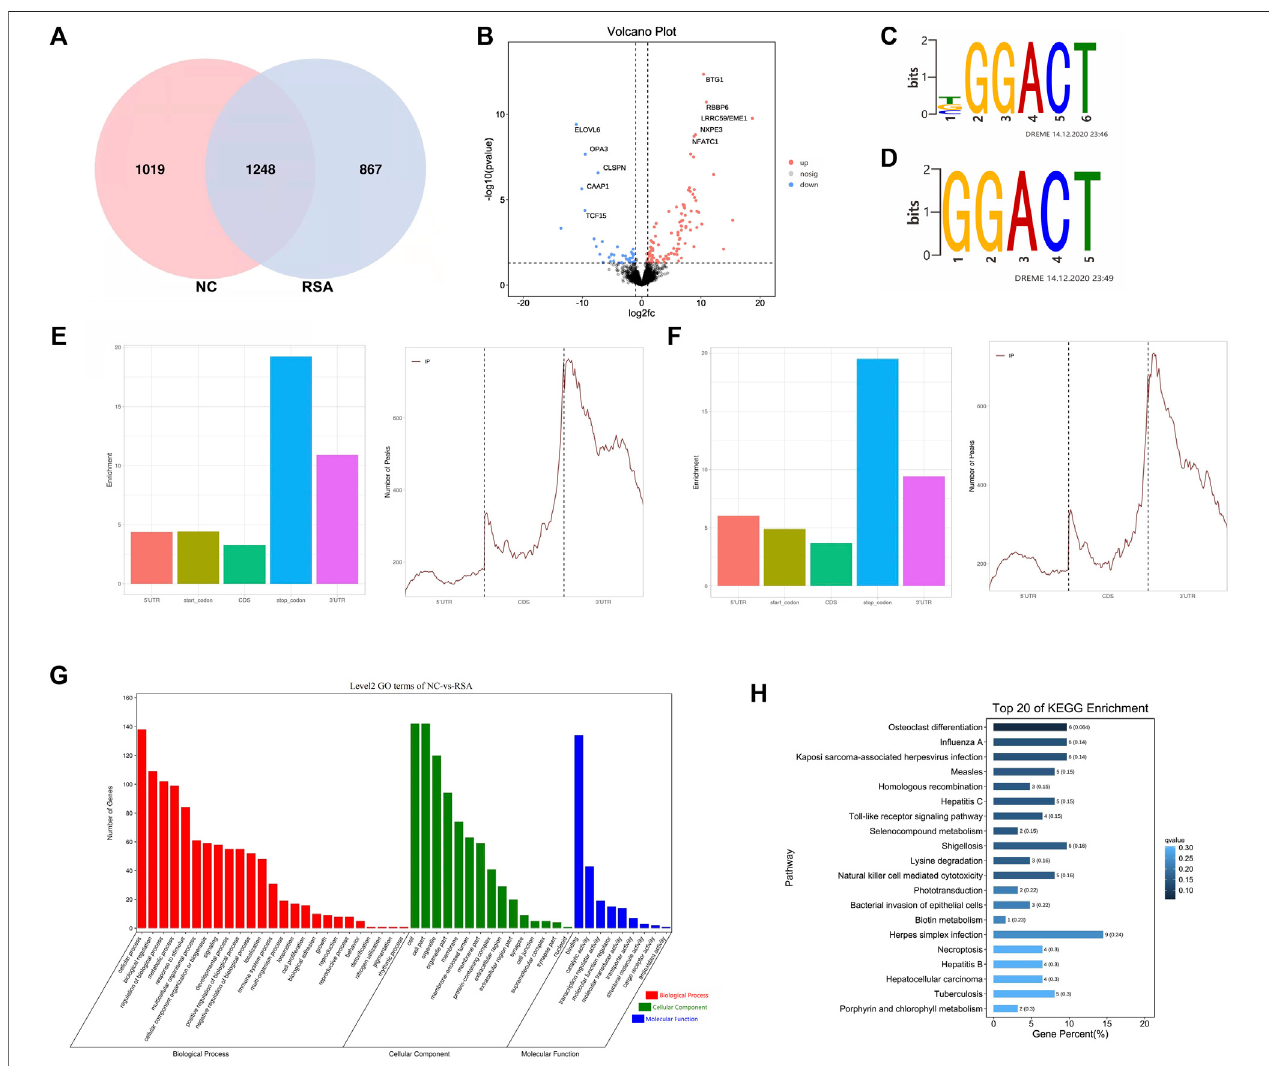
FIGURE 1 | Overview of m 6 A modi fi cation pattern in the RSAs and controls. (A) Venn diagram of the m 6 A modi fi cation peaks in villous tissues of RSA and control groups showing the overlapping m 6 A modi fi cation peaks of the two groups. (B) Volcano plot showed that there were 101 hyper-methylated and 37 hypo-methylated m 6 A peaks (fold change > 2, p < 0.05) in RSAs compared with controls. (C,D) Top m 6 A motifs enriched from all identi fi ed m 6 A peaks in RSA and control groups. (E) Distribution of m 6 A modi fi cation peaks in the villous mRNA transcriptome of the control group. (F) Distribution of m 6 A modi fi cation peaks in the villous mRNA transcriptome of the RSA group. (G) Gene Ontology (GO) analysis was performed on genes with signi fi cantly different m 6 A modi fi cation between the two groups. (H) Kyoto Encyclopedia of Genes and Genomes (KEGG) analysis performed on genes with signi fi cantly different m 6 A modi fi cation between the two groups and the top 20 are